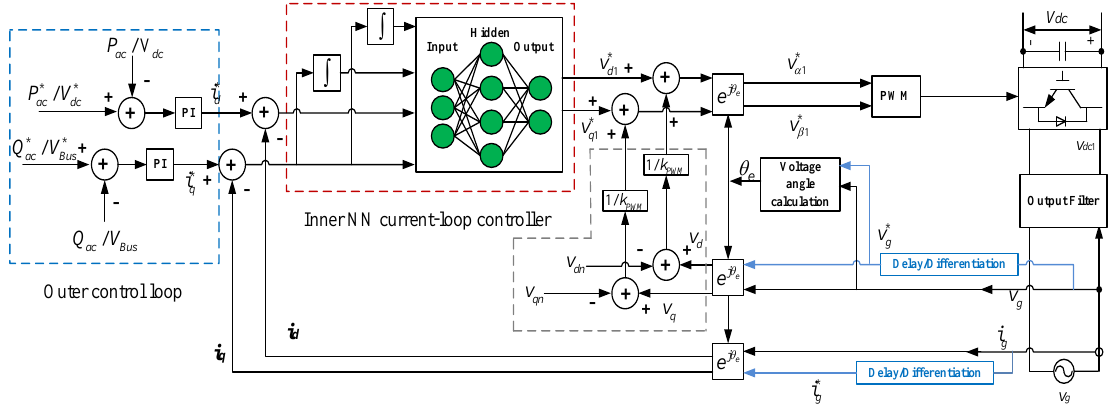
Figure 3. Neural network vector control architecture for a single-phase